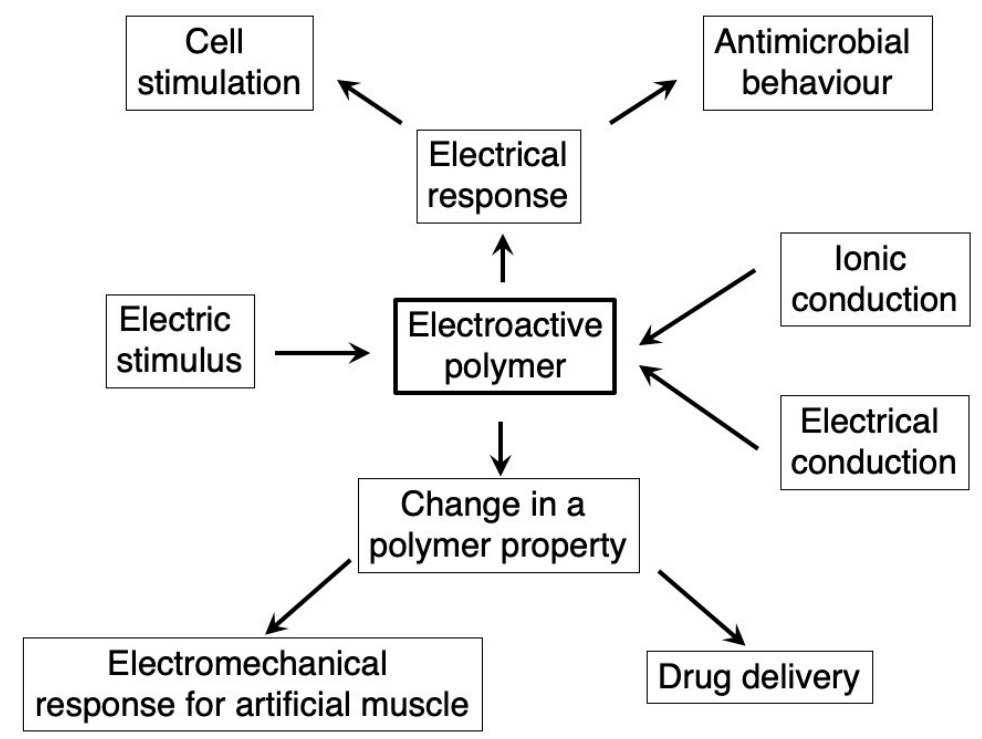
Figure 2. A general overview of electroactive polymers. The mechanism for the specific response to an electric stimulus can be through ionic or electric conduction. These mechanisms can trigger either a direct electric current to the material and the medium producing cell stimulation, or antimicrobial behavior or a change in some polymer properties, producing an electromechanical behavior and specific drug